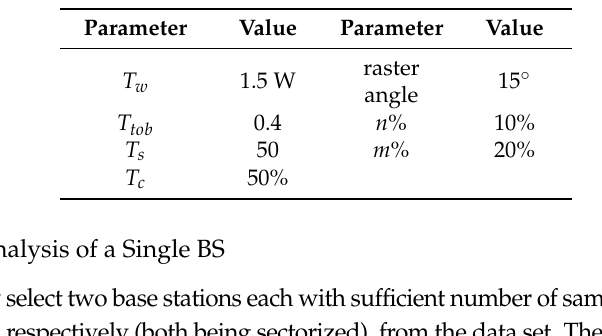
Table 1. Settings of Algorithm Parameters.